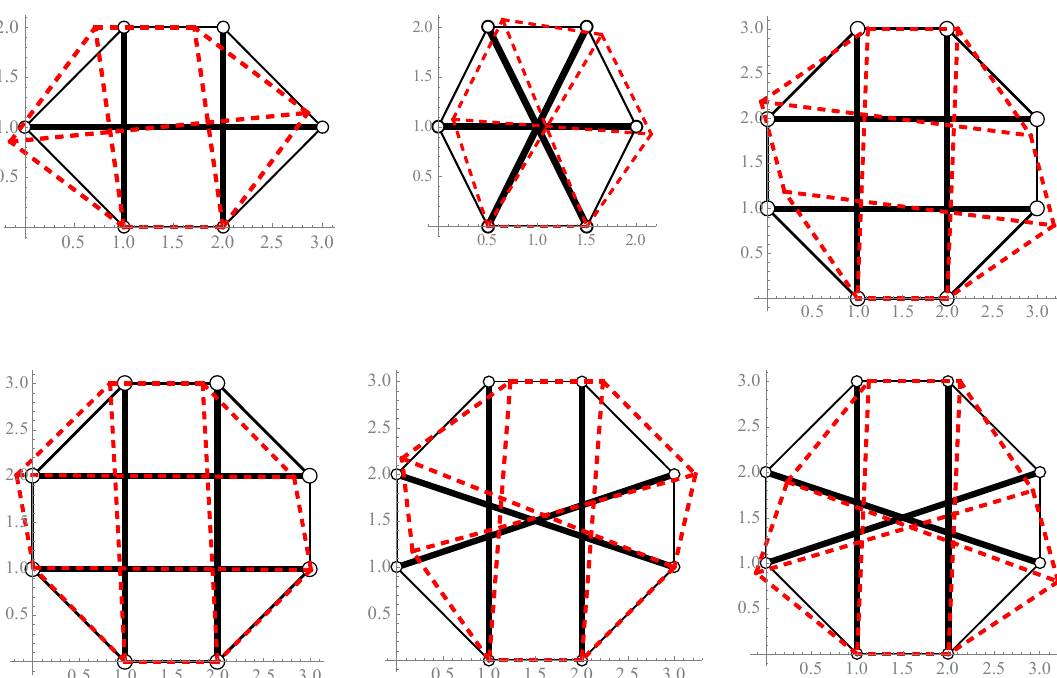
Figure 8. Values of self-stress state for four pure tensegrity trusses ( a - d ).